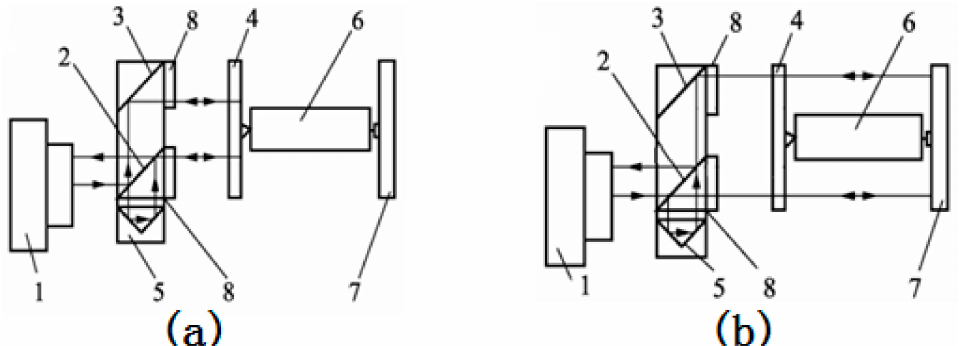
Figure 2. The layout of light path based on the etalon. ( a ) Description of the layout of the reference light path based on the etalon. ( b ) Description of the layout of the measurement light path based on the